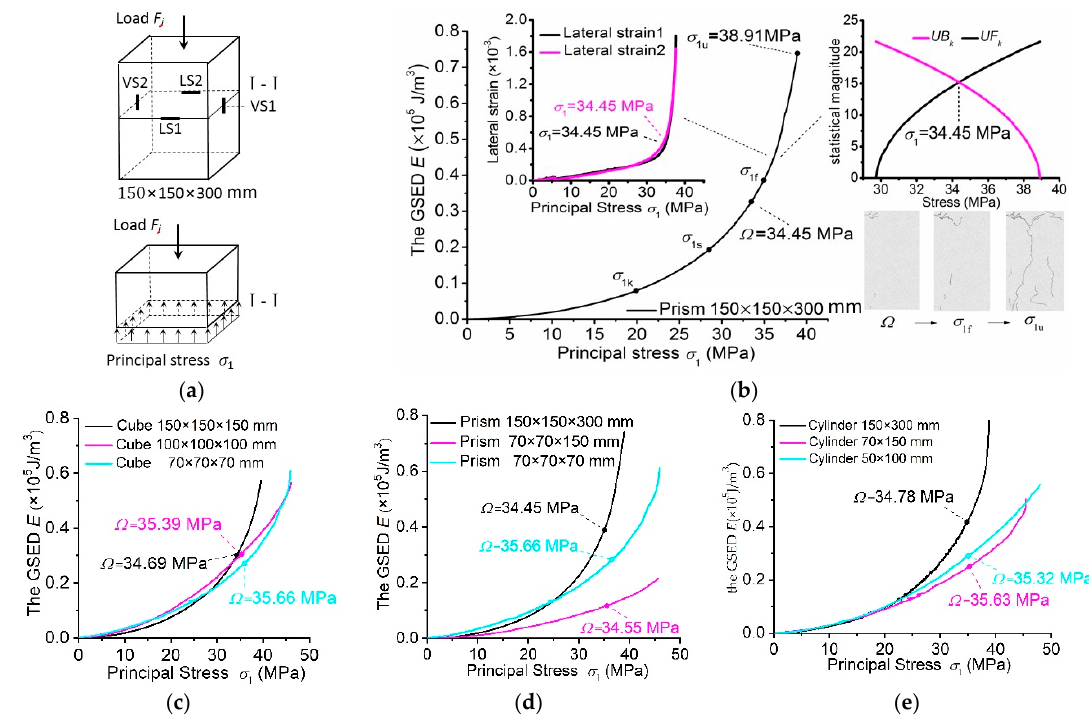
Figure 1. Investigation of the uniaxial stressing states of specimens. ( a ) The stress state of a prism specimen on the middle cross-section I-I and the lateral / vertical strain gauges LS / VS; ( b ) the E − σ 1 curve of the concrete specimen and its characteristic points σ 1k , σ 1s and Ω detected by the M-K criterion, as well as the average ultimate stress σ 1u ; ( c – e ) The characteristic points ( Ω ) in the E − σ 1 curves of cube, prism and cylinder concrete specimens at their failure loads. Compressive stress is positive